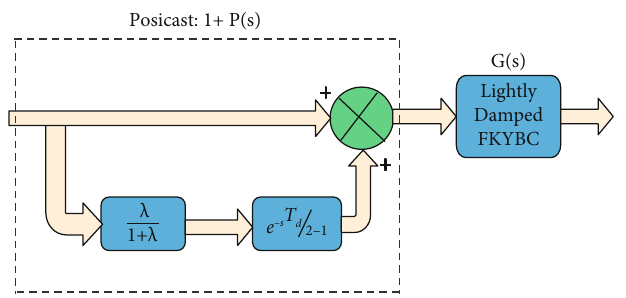
Figure 4: The classical half-cycle posicast.